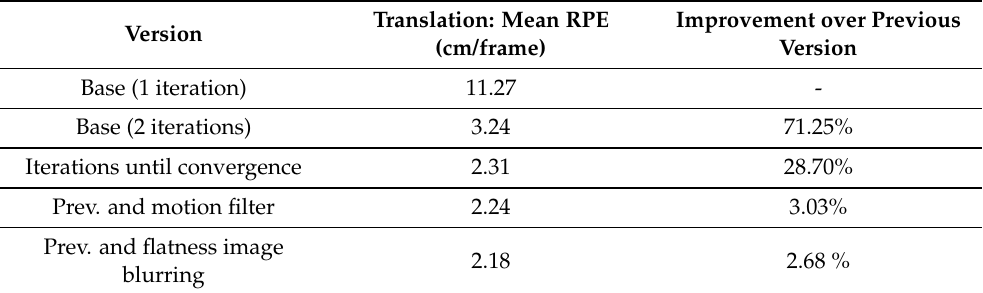
Table 4. Improvements in accuracy of the different versions of the proposed